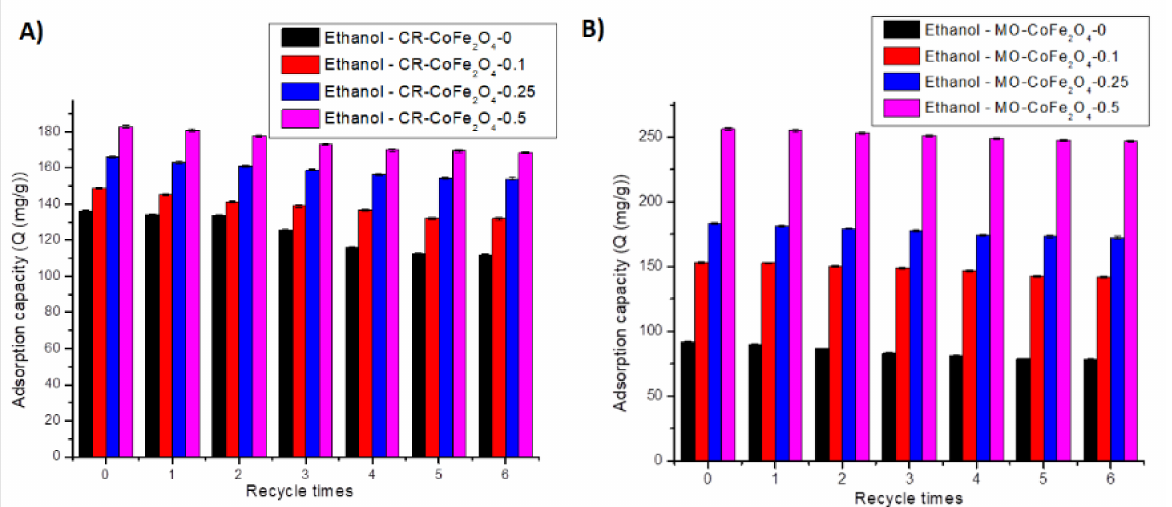
Figure 21. Reusability of CoFe 2 O 4 samples for CR ( A ) and MO ( B ).